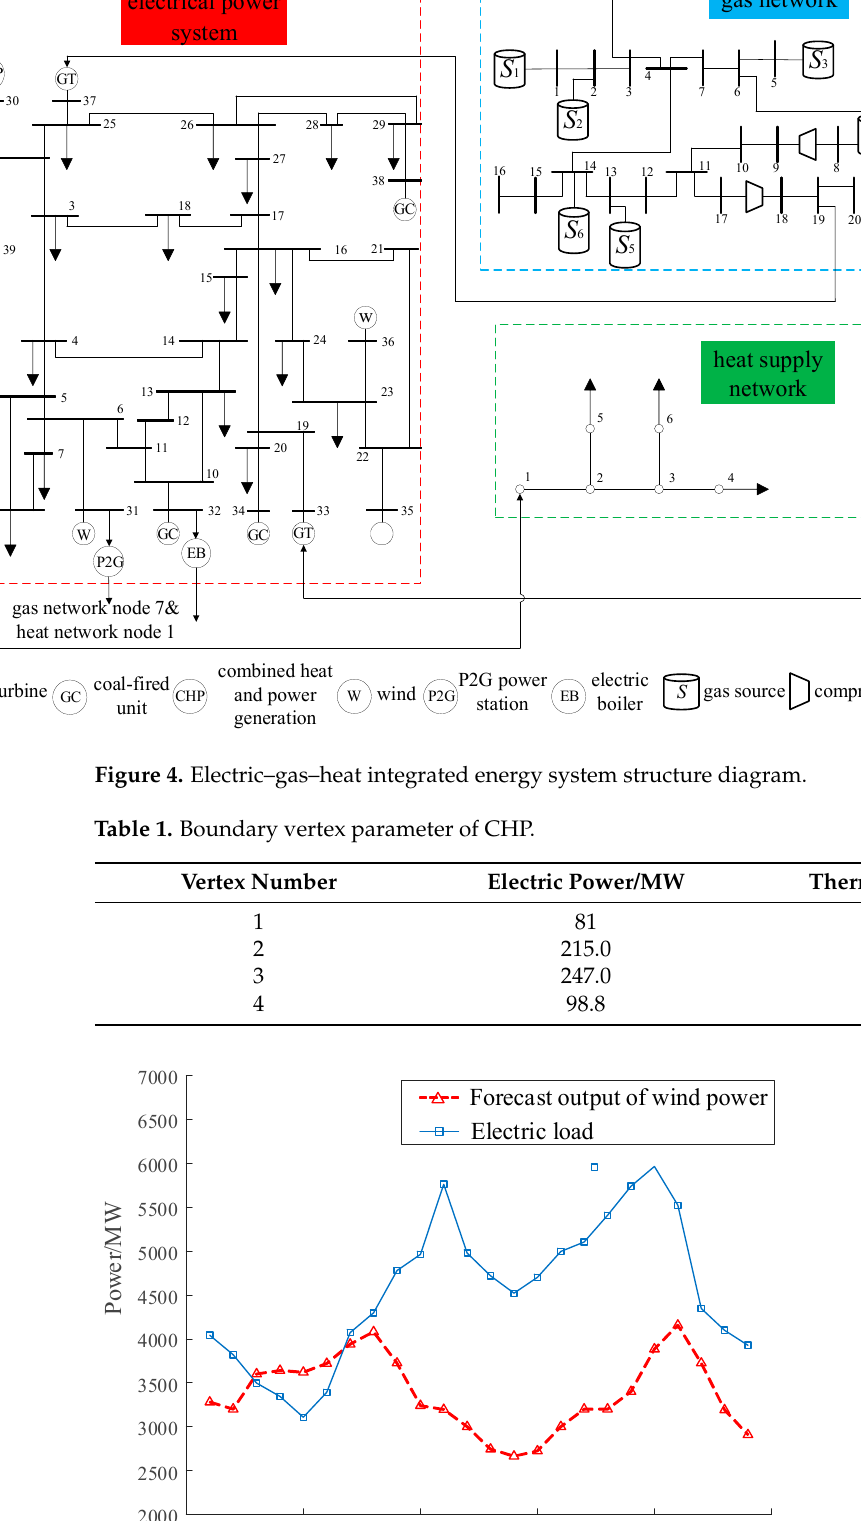
Figure 5. Output power forecasting of wind power and load.